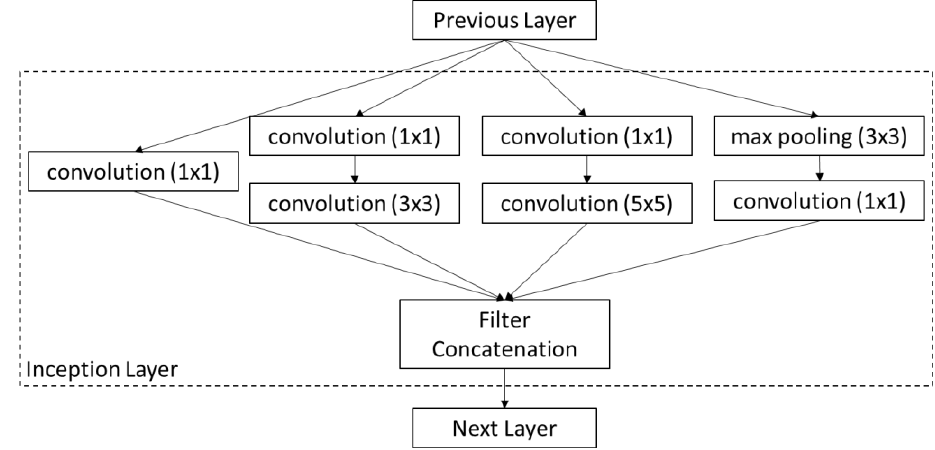
Figure 7. Inception layer with dimensionality reduction (adapted from [54]).